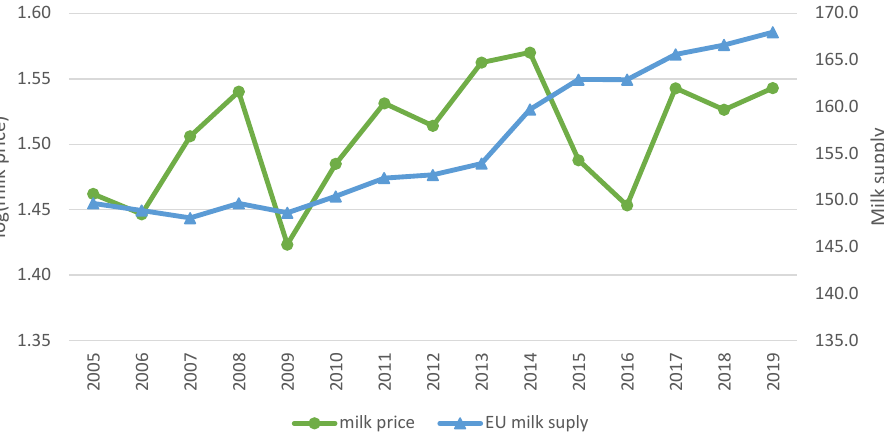
Figure 2. Milk price evolution. Source: Authors’ elaboration based on DG AGRI’s Milk Market Ob- servatory.